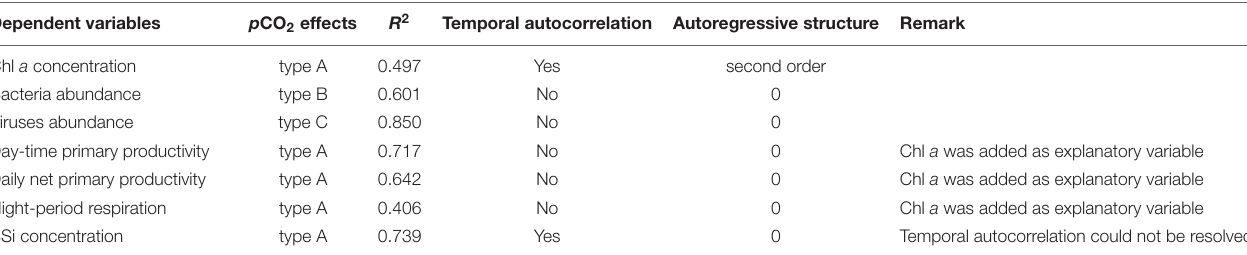
FIGURE 3 | Temporal variations of Chl a concentration (A) and the ln scale of Chl a concentration (B) in HC (1000 ppmv) and AC ( ∼ 410 ppmv) treatments. Data are means ± SD of replicates for HC treatments and for AC treatments. TABLE 1 | The GAMM analyses results of Chl a concentration, the abundance of viruses and bacteria, BSi concentration, primary productivity and night